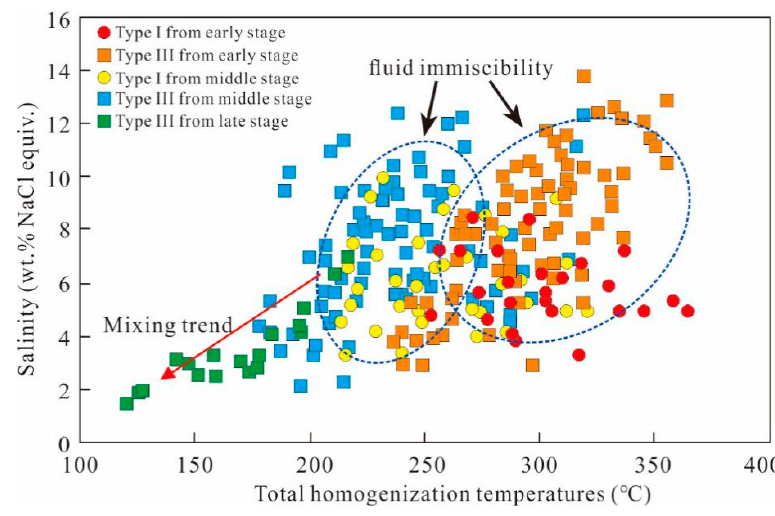
Figure 11. Total homogenization temperature versus salinity of fluid inclusions in the mineralization stages of the Liyuan gold deposit.